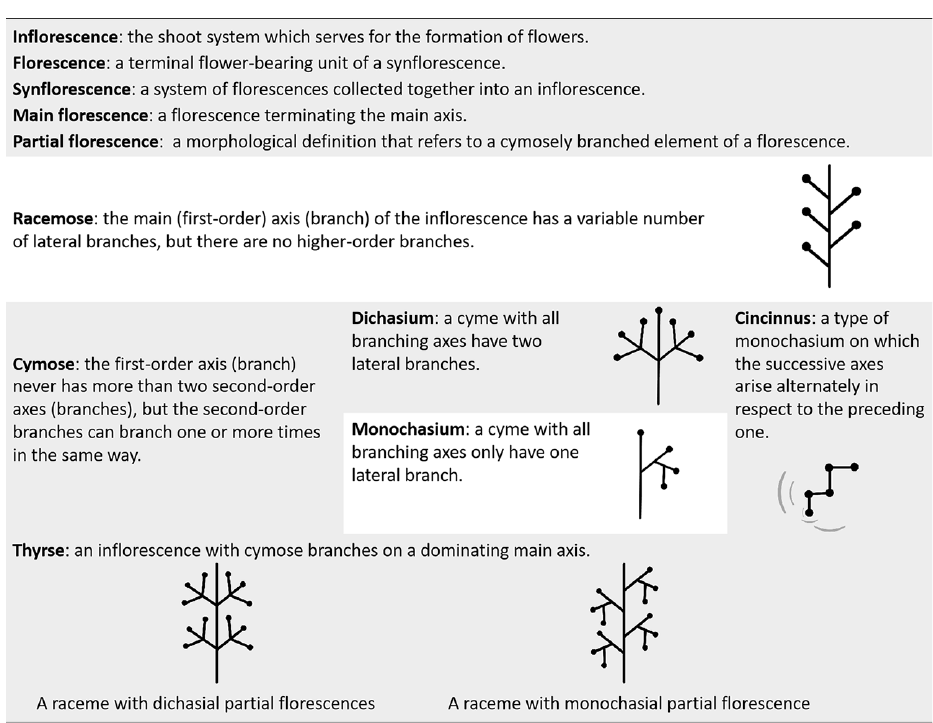
Figure 1. Terminology of inflorescence morphology.